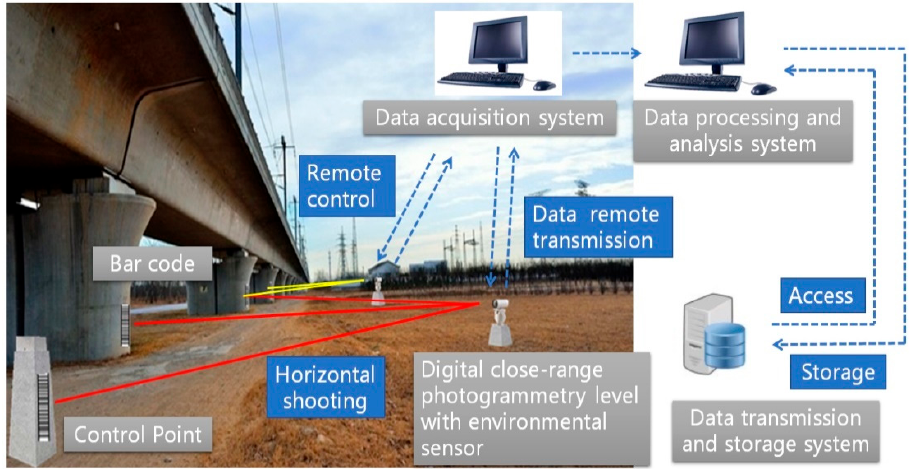
Figure 1. The architecture of the settlement monitoring system of photogrammetry.